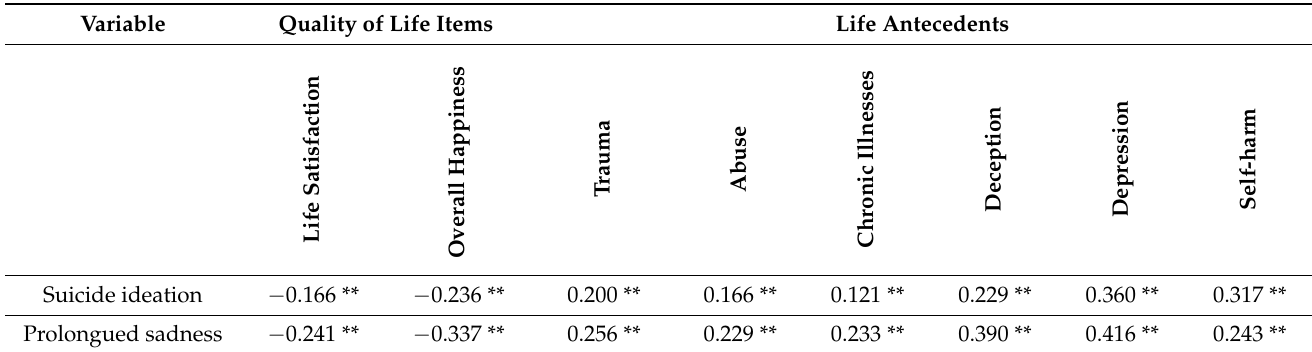
Table 2. Correlations between suicide ideation/prolonged sadness, and quality of life dimension/life antecedents.